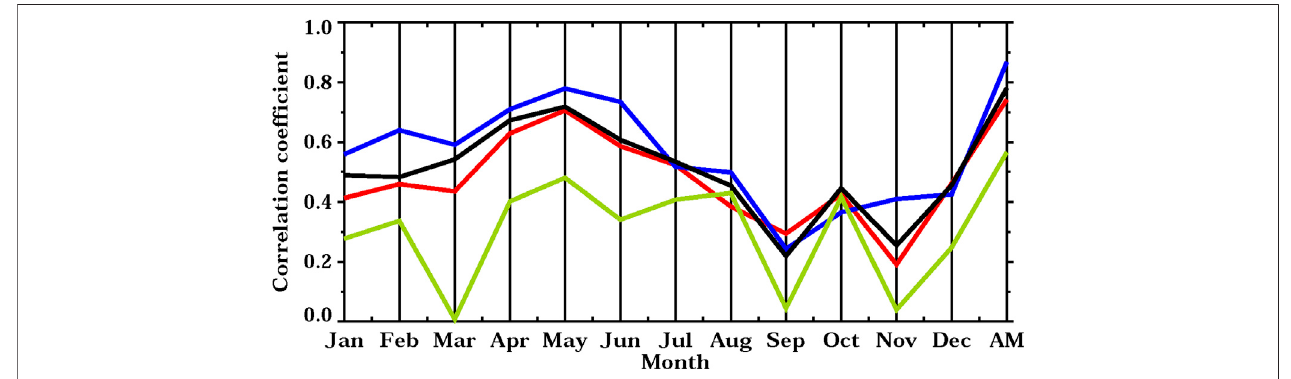
FIGURE 4 | Correlation coefficients between the TCO over Arosa/Davos and near-global (red line), northern hemisphere (blue line), southern hemisphere (green line), and the global (black line) means.